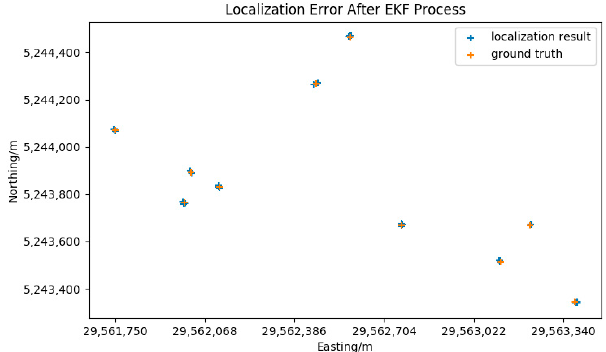
Figure 14. Comparison of localization results and ground truth coordinates, after EKF processing.